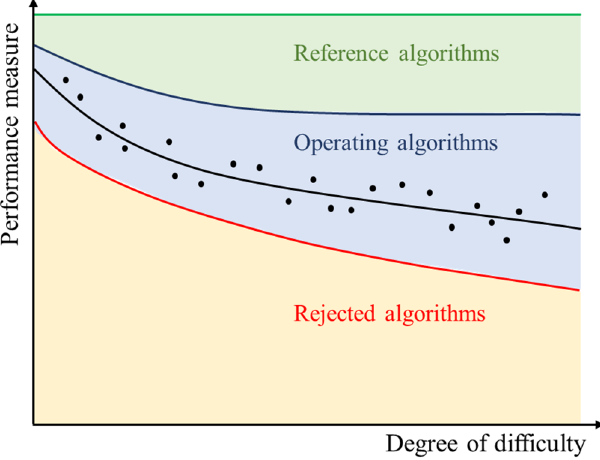
Figure 13. Performance measure vs. of degree of difficulty for a given algorithm under test.